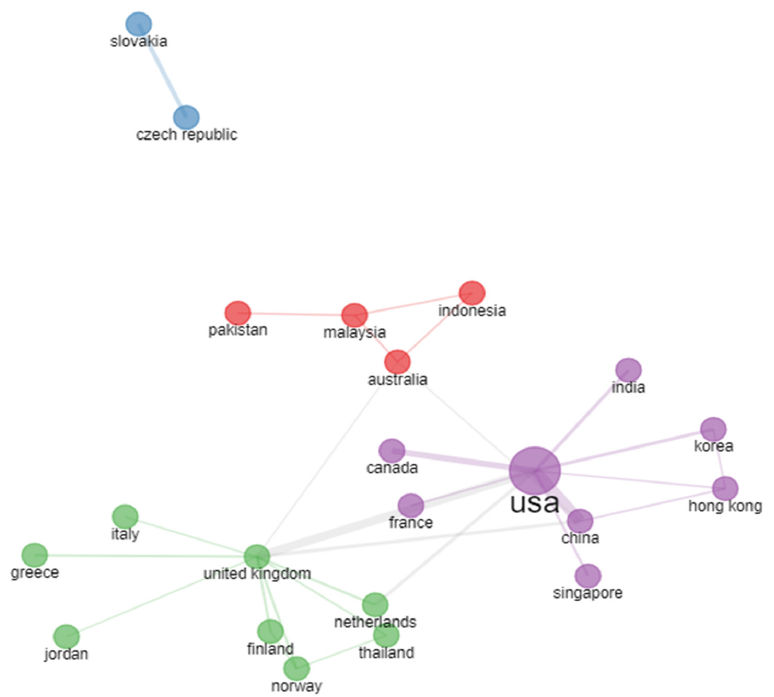
Figure 8. Geographic Heat Map of Countries Contributing to EVA Research.